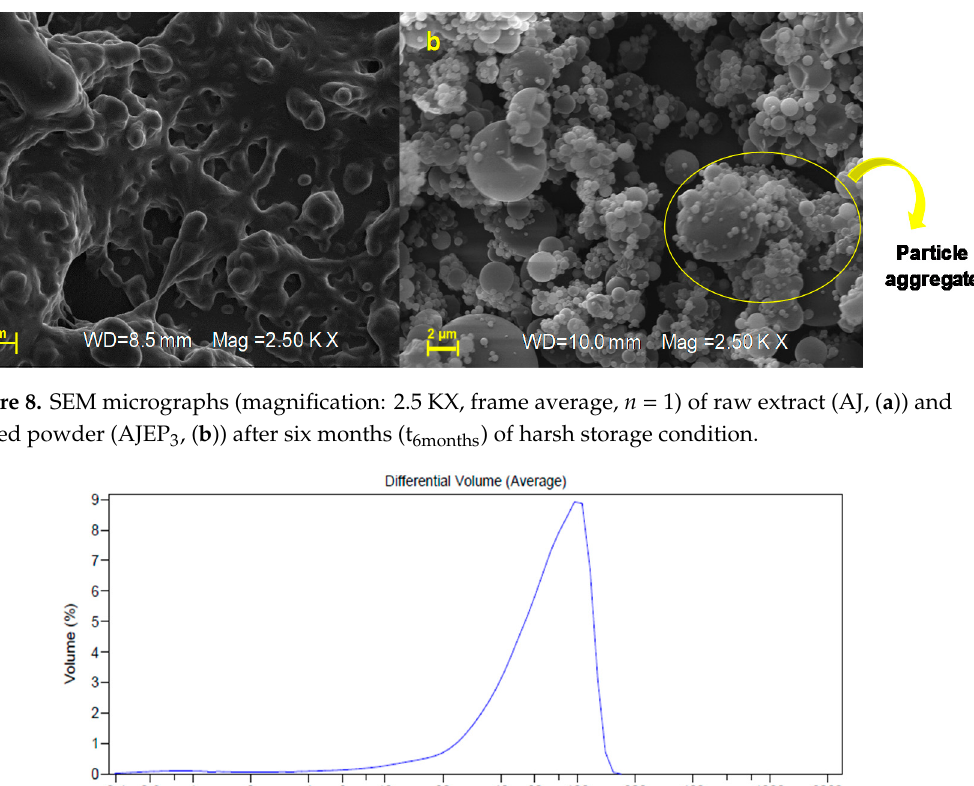
(t 6months ) of harsh storage conditions.